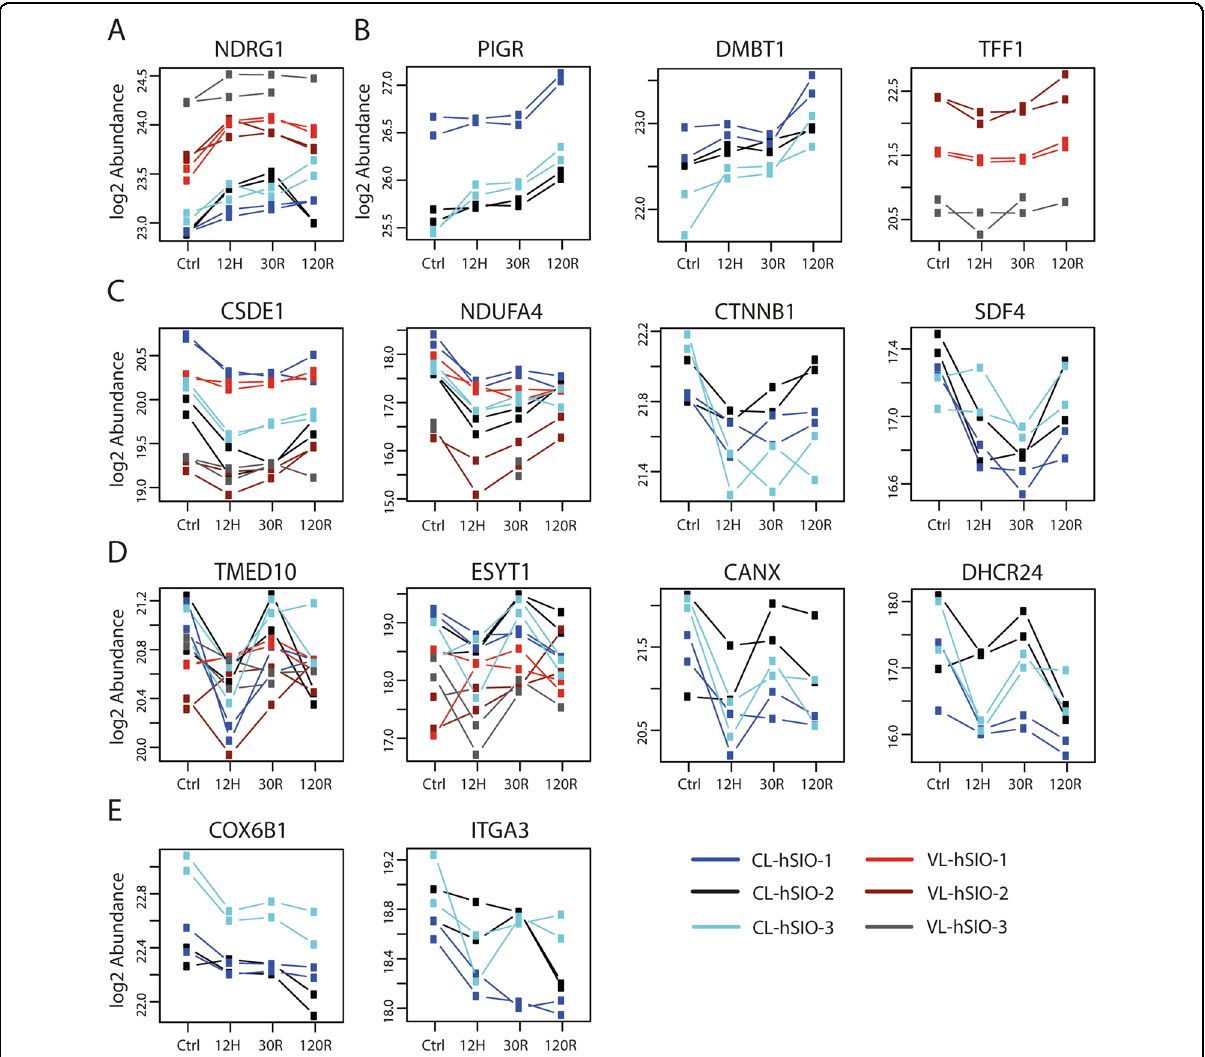
Fig. 4 Temporal expression pro fi les. Proteins showing a consistent temporal pro fi le in both CL and VL organoids, or either CL or VL organoids are shown. Pro fi les are clustered in fi ve groups which are presented in panels A , B , C , D , and E . Temporal pro fi le analysis was performed using R package MaSigPro, and temporal pro fi les were considered statistically different using an R -squared ≥ 0.5 and a adjusted p -value < 0.3. See also Fig. S4, in which all signi fi cant pro fi les can be found. NDRG1 N-Myc downstream regulated 1, PIGR polymeric immunoglobulin receptor, DMBT1 deleted in malignant brain tumors 1, TFF1 trefoil factor 1, CSDE1 cold shock domain containing E1, NDUFA4 cytochrome c oxidase subunit, CTNNB1 Β -catenin,